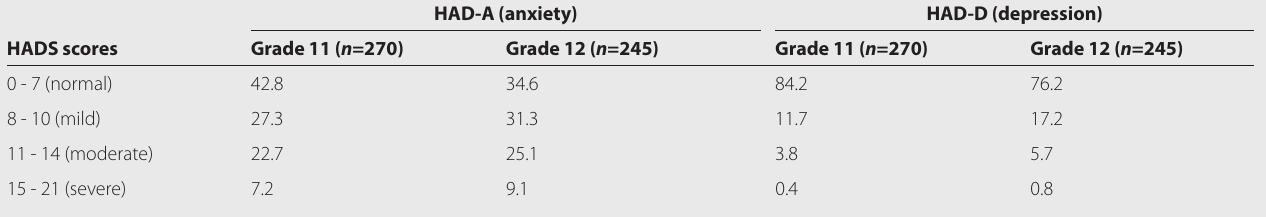
Table 2. Anxiety and depression scores of Grade 11 and 12 learners expressed in percentage of learners per category HADS scores